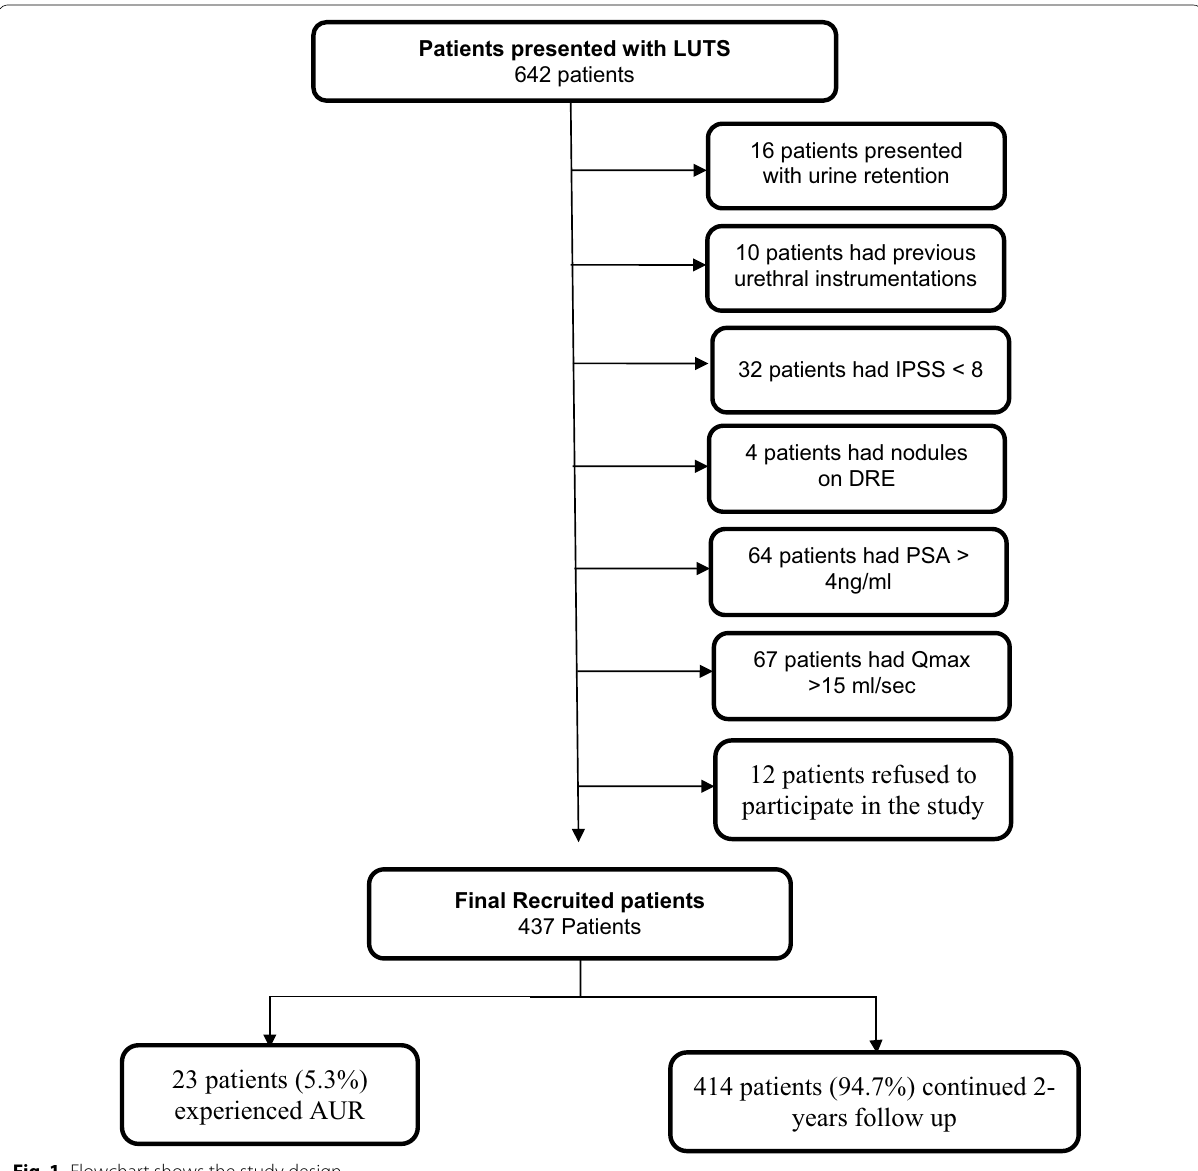
Fig. 1 Flowchart shows the study